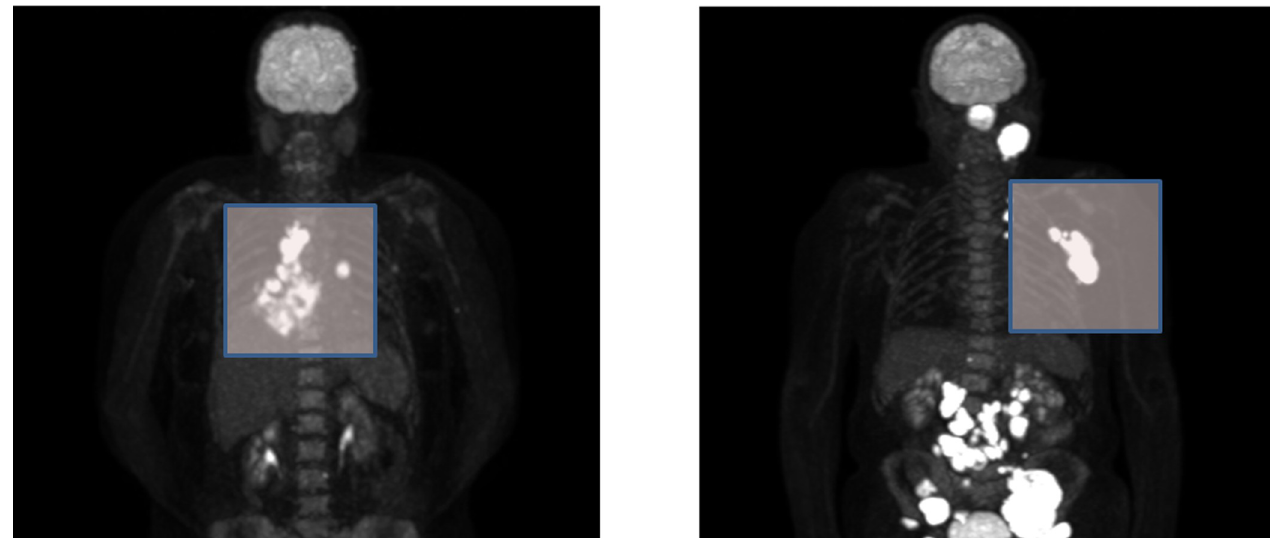
Fig 7. Maximum intensity projection of Patient 1 (left) and patient 2 (right). The tumors used for feature calculation are marked in the images. Tumors were manually segmented and used for computation of radiomic features.